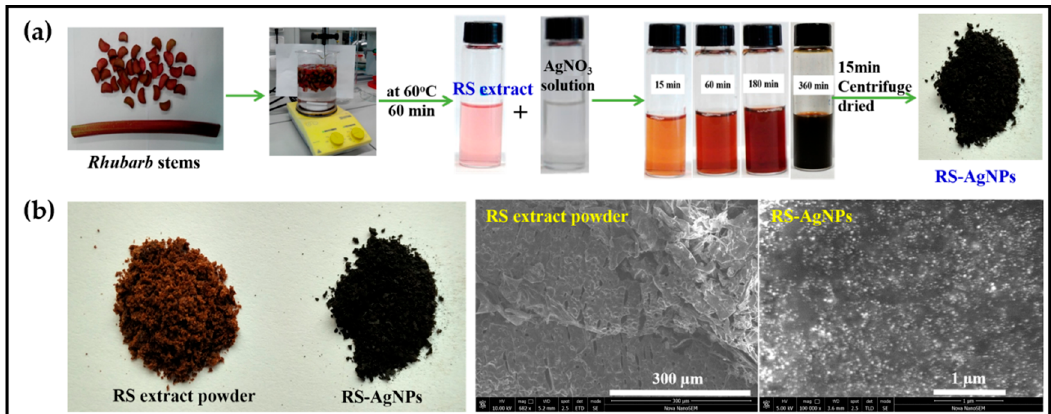
Figure 5. ( a ) Synthesis of RS-AgNPs from Rhubarb stem extract (RS extract), ( b ) Pictograph and SEM morphology of RS extract and RS-AgNPs. Adopted from [91], with permission from Springer, 2018.